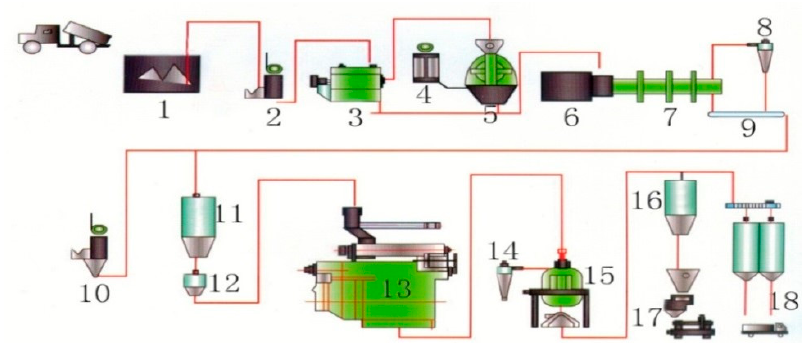
Figure 3. Typical schematic diagram of CSDF processing [36]. 1: Storage yard; 2: Conveyor; 3: Sieving machine; 4: Cyclone dust removal; 5: Intermediate bunker; 6: Hot-blast stove; 7: Dryer; 8: Separator;